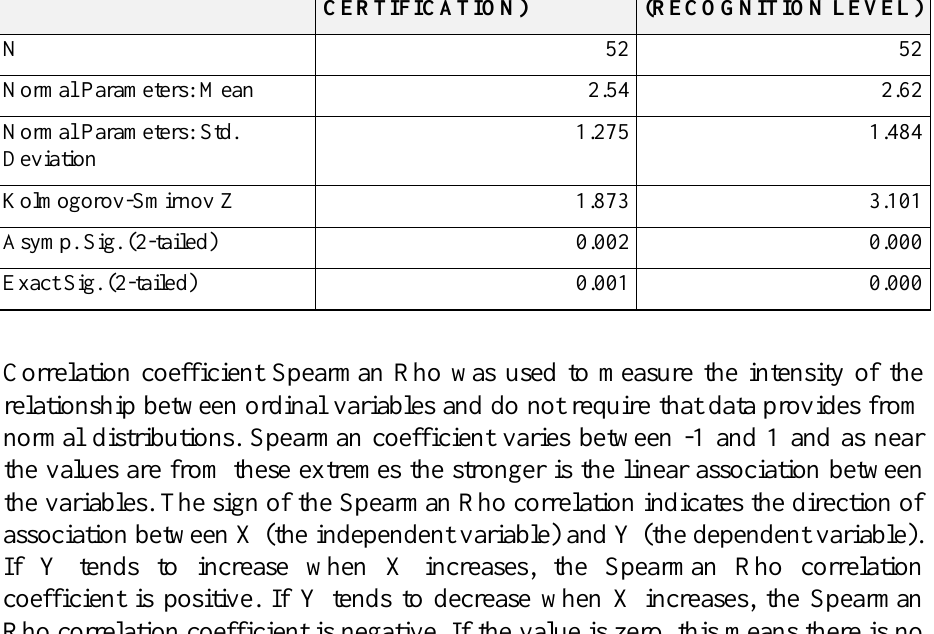
Table 5 – One-Sample Kolmogorov-Smirnov Test Parameter Y ISO 9001 (YEARS